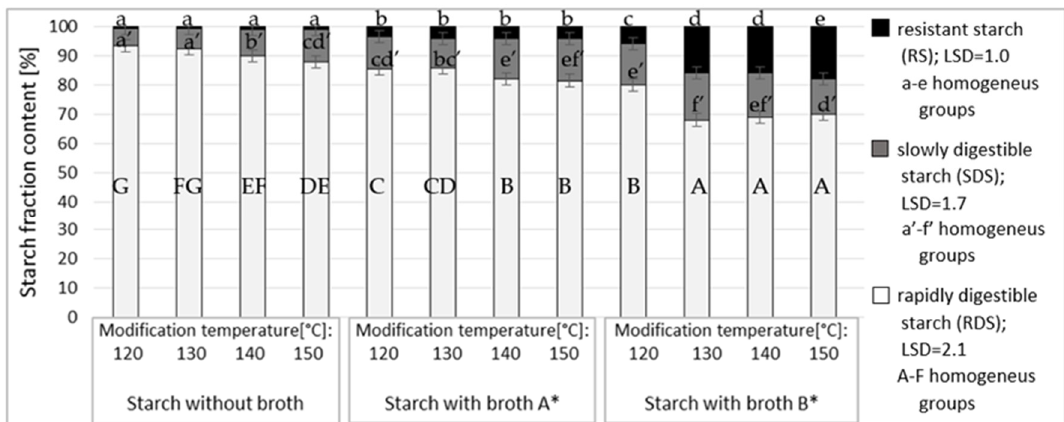
Figure 4. E ff ect of modification temperature on the resistance of starch esters. * Broth A— α -ketoglutaric acid 60 g / L;—citric acid 18 g / L; pyruvic acid 1 g / L. Broth B— α -ketoglutaric acid 49 g / L; citric acid 46 g / L; pyruvic acid 1.5 g / L.